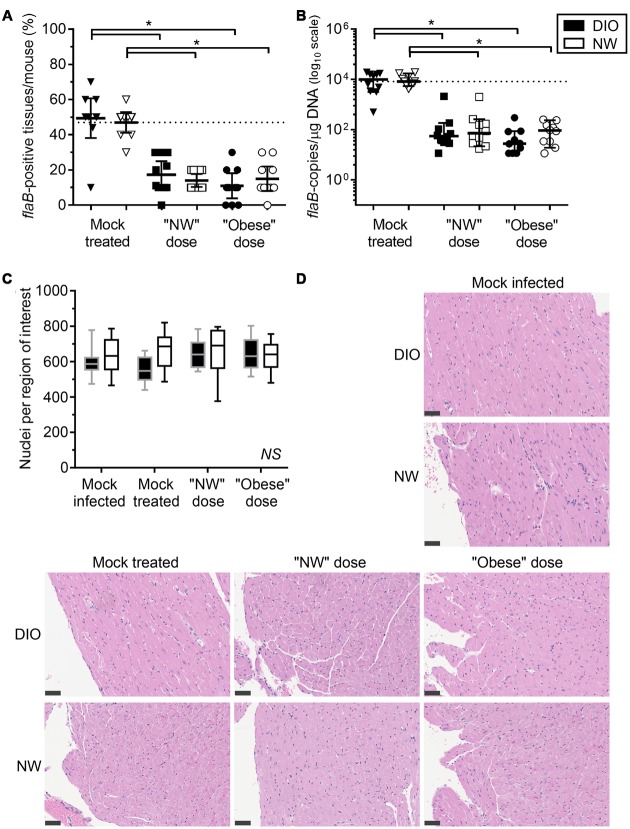
Diet-induced obesity has no effect on tissue clearance of B. burgdorferi in antibiotic-treated mice. Bacterial DNA in tissues of mice was quantified by qPCR with primers specific to the B. burgdorferi flaB gene. DIO mice are shown in black and NW mice in white. Individual values from mock-treated groups are depicted as triangles. Squares and circles stand for values measured in groups treated with “NW” and “Obese” doses of tigecycline, respectively. (A) Percentage of qPCR-positive tissues per mouse. Dotted line represents the average percentage of positive tissues in NW mock-treated mice (47%). Bars correspond to means with 95% CI. (B)
flaB DNA copy number in all tissues of individual mice, calculated from individual copy numbers measured in ear, bladder, skin, knee joint (patella), brain, kidney, quadriceps, heart, lung and liver. Copy number is normalized to 1 μg of total host and bacterial DNA in each sample (data for individual tissues are provided in Supplementary Figures S1 and S2). Dotted line represents the median flaB DNA copy number in tissues of mock-treated NW mice (8.4ˆ103
flaB DNA copies/μg DNA). Bars display medians with 95% CI. (C,D) Carditis severity. Sagittally hemisected hearts were fixed and stained by hematoxylin and eosin (H&E). (C) Numbers of nuclei per 100 mm2 region of interest, calculated from counts obtained in five regions of interest (each atrium and ventricle and the heart apex) in three matched H&E stained sections of heart. DIO mice are shown in black (gray margins) and NW mice in white. Means with 95% CI are shown. (D) Representative heart sections. Bars correspond to 50 μm (40x magnification). ∗indicates p < 0.05 (two-way ANOVA with Holm-Sidak post-tests; values in (B) were log-transformed prior to statistical analysis). NS, no significant differences among any groups (two-way ANOVA with Holm-Sidak post-tests).